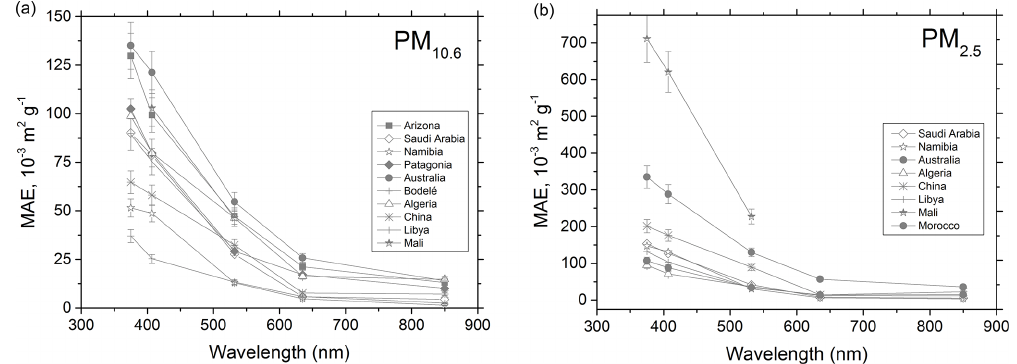
Figure 3. Spectral dependence of the MAE values for the samples investigated in this study in the PM 10 . 6 (a) and in the PM 2 . 5 (b) mass